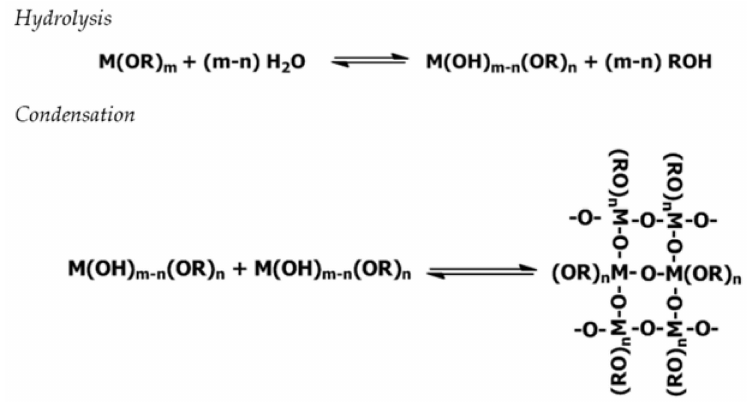
Scheme 1. Idealized representation of the inorganic network formation by sol-gel